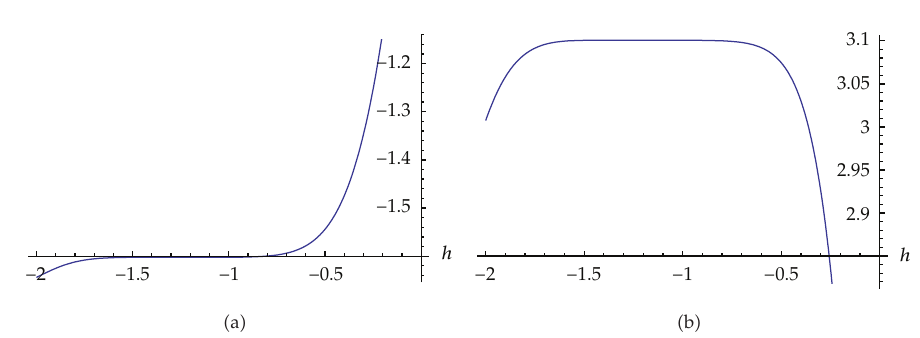
Figure 1: (cid:2) a (cid:3) The h curve of system (cid:2) 1.1 (cid:3) for u (cid:2) 3 , 1 (cid:3) obtained from the 10th order HAM. (cid:2) b (cid:3) The h curve of system (cid:2) 1.1 (cid:3) for v (cid:2) 3 , 1 (cid:3) obtained from the 10th order HAM.